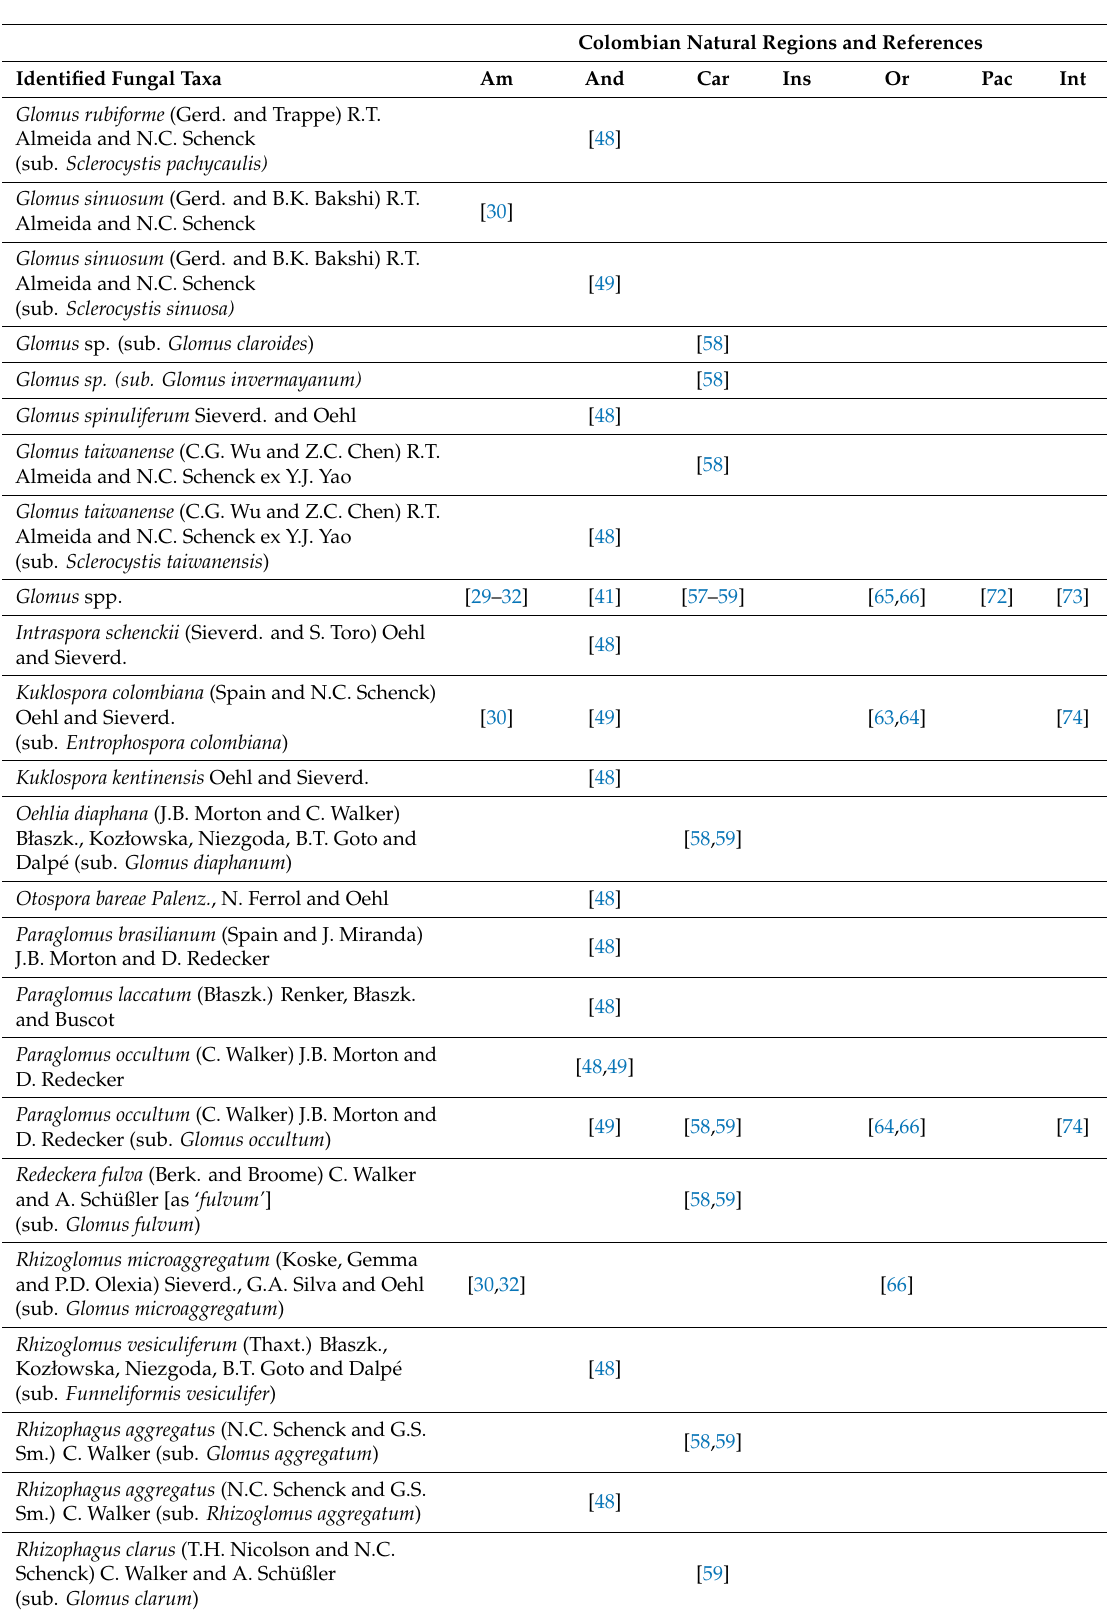
Table 1. Cont . Colombian Natural Regions and